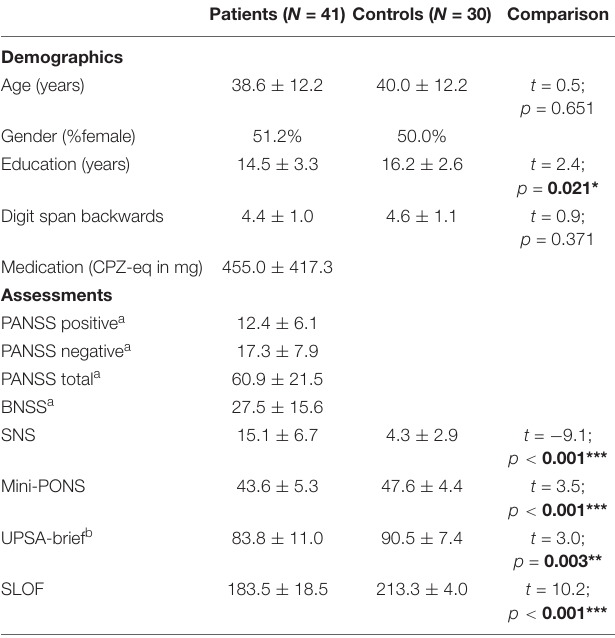
TABLE 1 | Demographic and clinical characteristics.